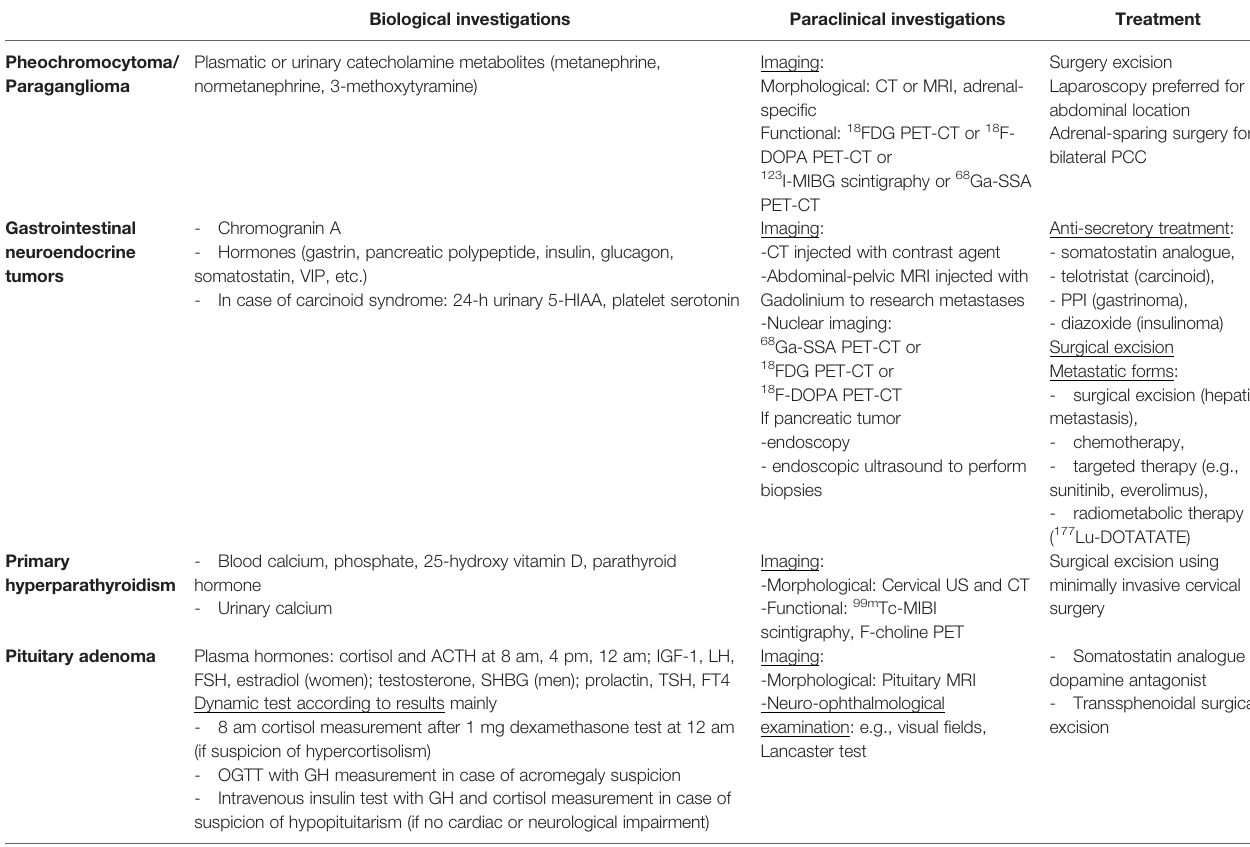
TABLE 5 | General guidelines for diagnosis and treatment of tumors of endocrine